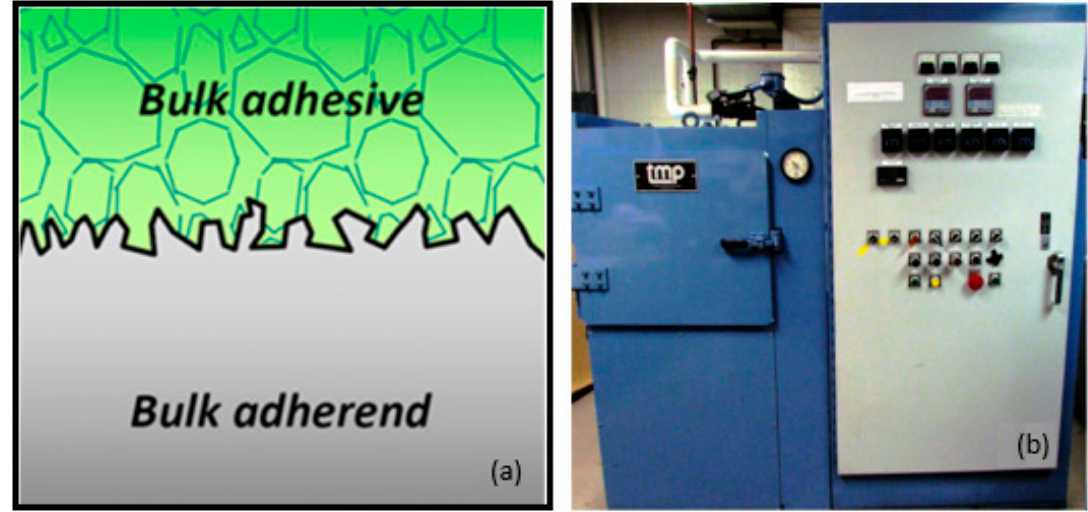
Figure 3. ( a ) Mechanical interlocking induced due to crevices produced by abrasion [42]. ( b ) Autoclave vacuum press machine used for curing the laminates.